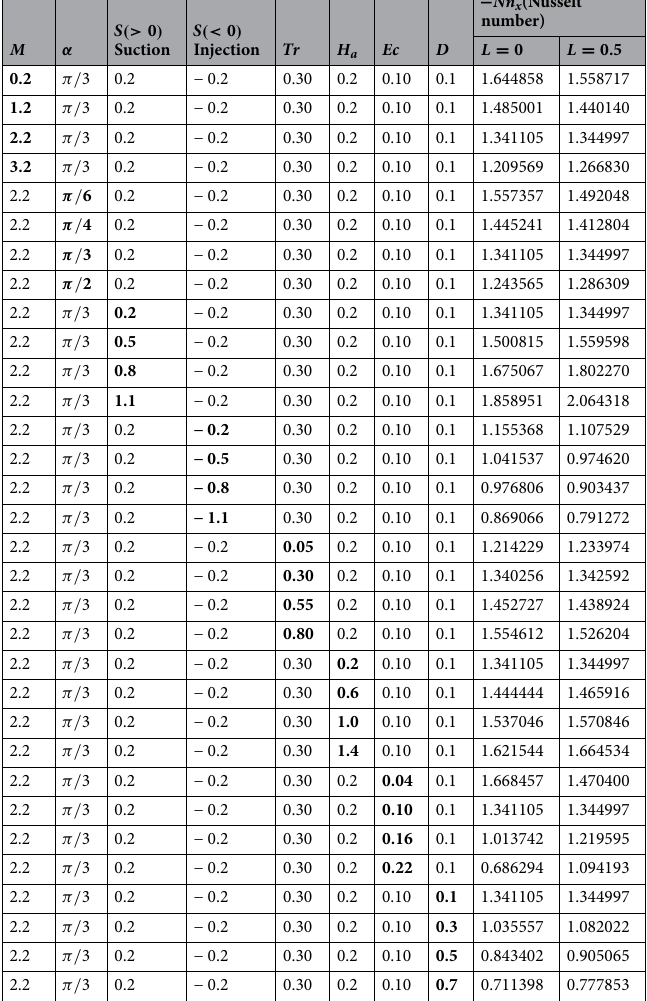
0.5 ) and without slip ( L 0 ) conditions. The = =